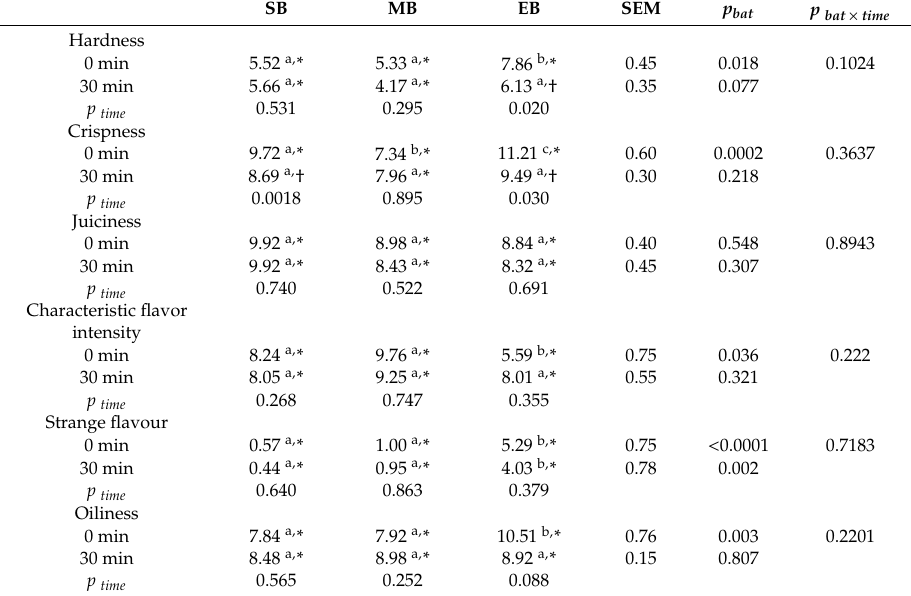
Table 5. Texture and flavor characteristics of fried samples as assessed by sensory analysis immediately and 30 min after sample